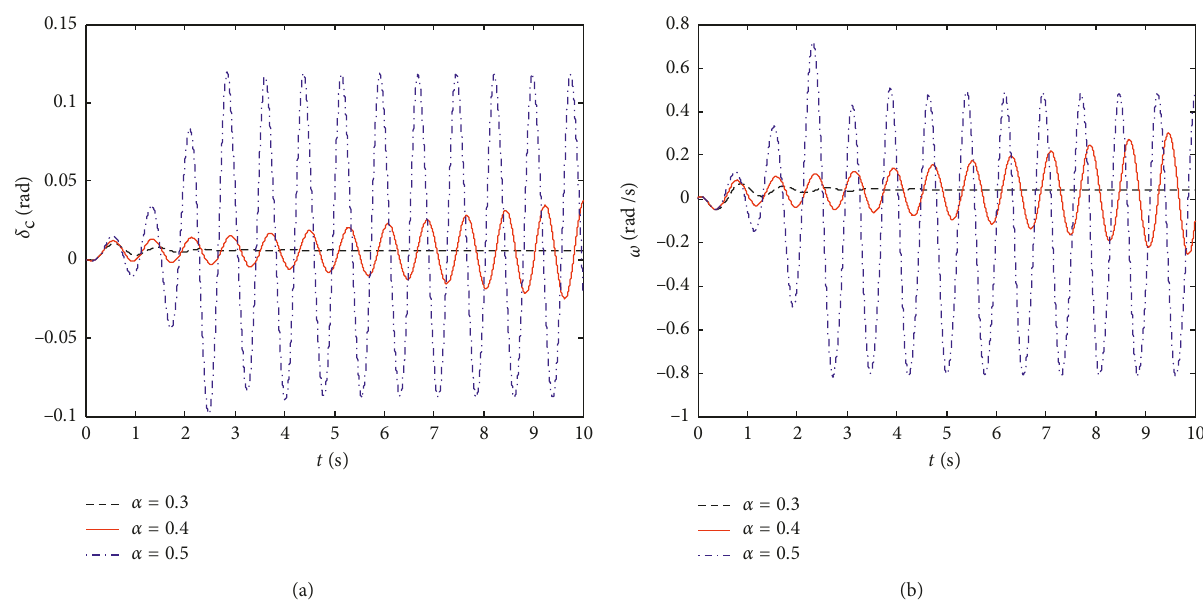
5 0 (cid:30) 0.5 × 10